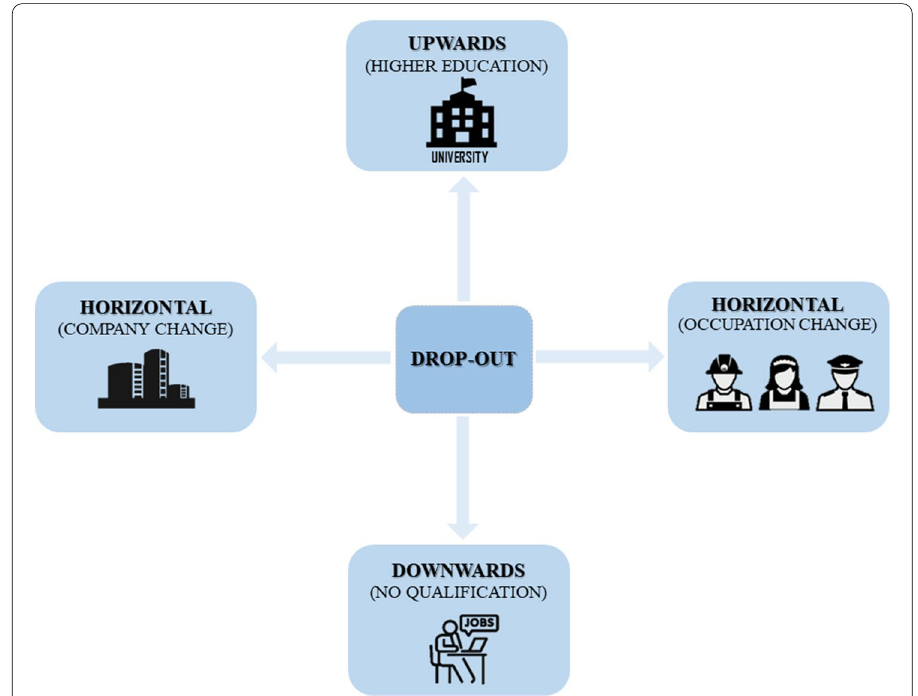
Fig. 1 Differentiation of drop-out directions (as an extension of Feß